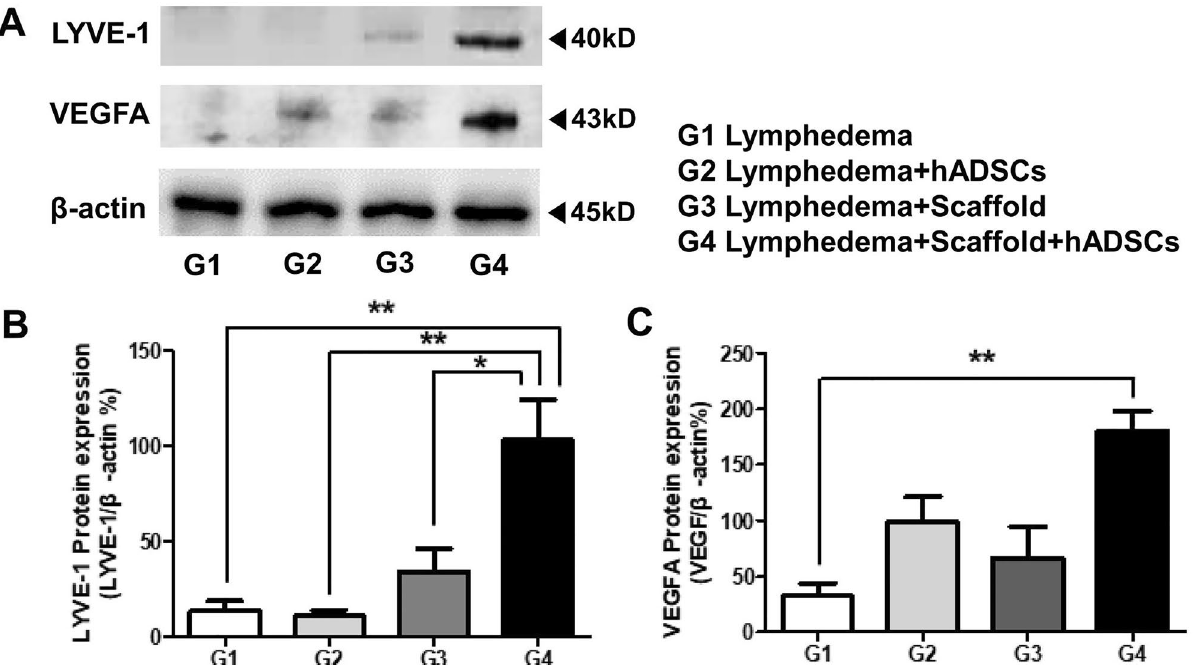
Figure 6. LYVE-1 protein expression after recellularizied lymph node scaffold transplantation. The expression level of the LYVE-1 protein was determined by Western blotting and higher in recellularizied lymph node scaffold group compared with other groups. Bar graphs were analyzed via blot intensities of densitometric scanning. Data are presented as means ± SEM (* P < 0.05, ** P < 0.01; n = 5 per group). LYVE-1, Lymphatic vessel endothelial hyaluronan receptor 1. Uncropped blots are included with supplemental data (Supplementary Fig.